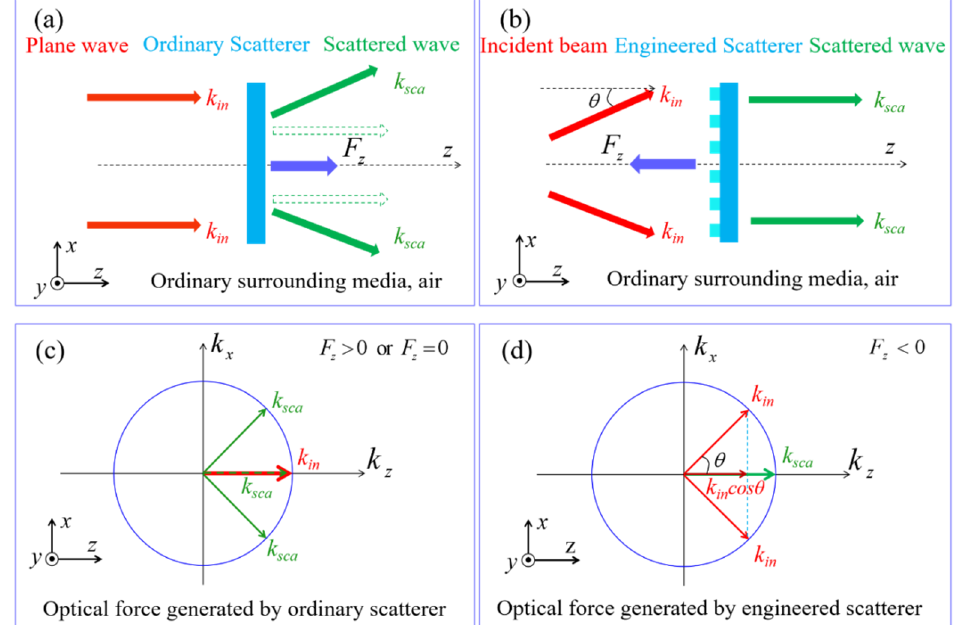
Figure 1. An engineered photonic probe converts the incident waves into waves propagating along the z -axis. ( a ) A plane wave with wave vectors ( k in ) parallel to the z -axis is scattered by an ordinary scatter. ( b ) An incident light with wave vectors ( k in ) nonparallel to the z -axis is scattered by an engineered scatterer. ( c ) The forward momentum of incident light (red arrow) decreases or remains constant after being scattered by the engineered scatter (green solid and dotted arrow, respectively). Thus, the axis optical force is positive or zero. ( d ) The forward momentum of incident light (red arrow) is enhanced after passing through the engineered scatterer (green arrow), and an OPF is obtained.